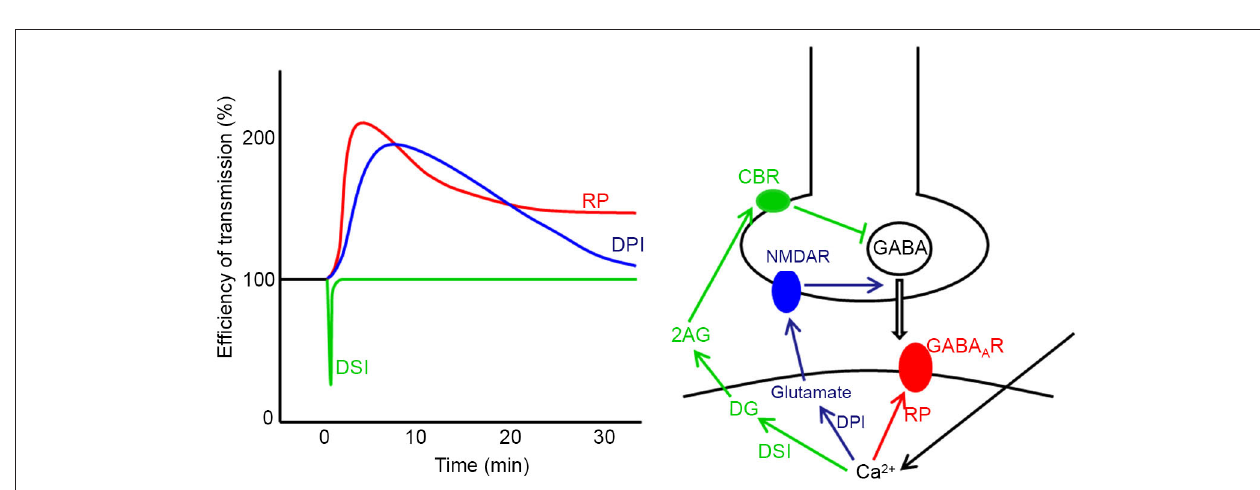
FIGURE 1 | Cerebellar cortical neuronal circuits. Mossy fibers from pontine nuclei etc., send excitatory synaptic outputs to granule cells. A granule cell forms one or a few excitatory glutamatergic synapses on a Purkinje cell, where LTD occurs depending on the activity of the granule cell and a climbing